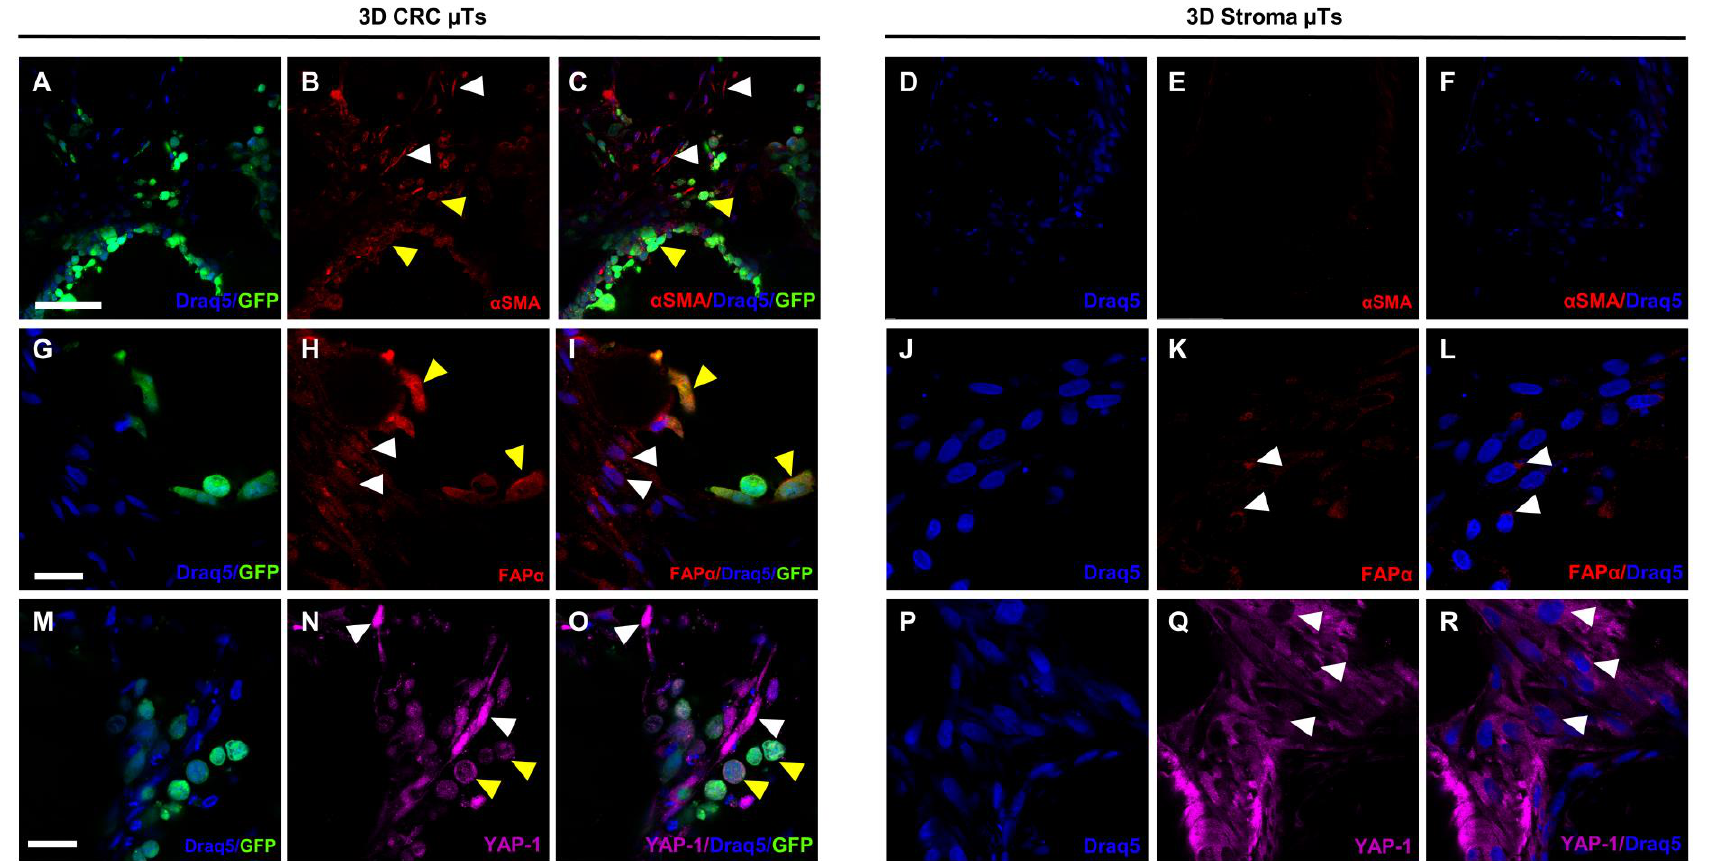
Figure 7. Immunofluorescence staining of the activation of Normal Fibroblasts (NFs) into Cancer-associated Fibroblasts (CAFs) in the 3D CRC μTs. ( A – C ) and ( D – F ): α -smooth muscle actin ( αSMA ) signal (red) in the 3D CRC μTs and the 3D Stroma μTs, respectively; scale bar : 100 µm. ( G – I ) and ( J – L ): Fibroblast Activation Protein α ( FAPα ) signal (red) in the 3D CRC μTs and the 3D Stroma μTs; scale bar : 50 µm. ( M – O ) and ( P – R ): Yes-associated protein 1 (YAP-1) signal (magenta) in the 3D CRC μTs and the 3D Stroma μTs; scale bar : 50 µm. CAFs and HCT-116 cells indicated by white and yellow arrows, respectively. Nuclear staining with Draq5 (blue) and green fluorescent protein (GFP) signal by HCT-116 cells (green).